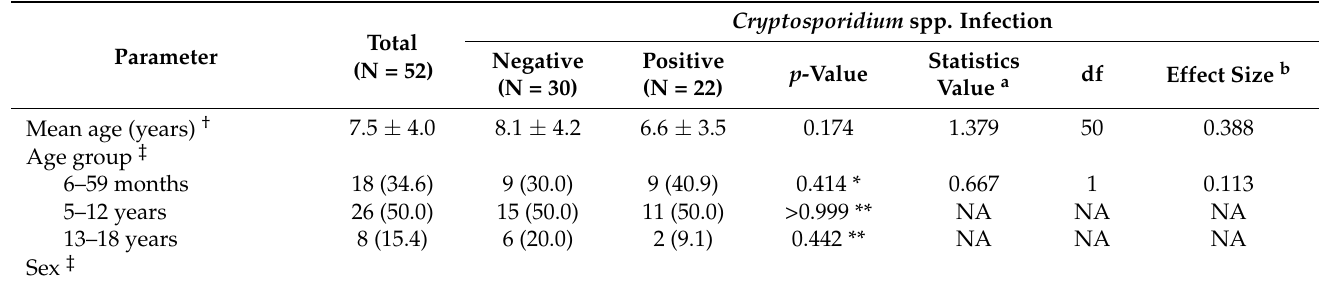
Table 1. General characteristics and clinical findings of study